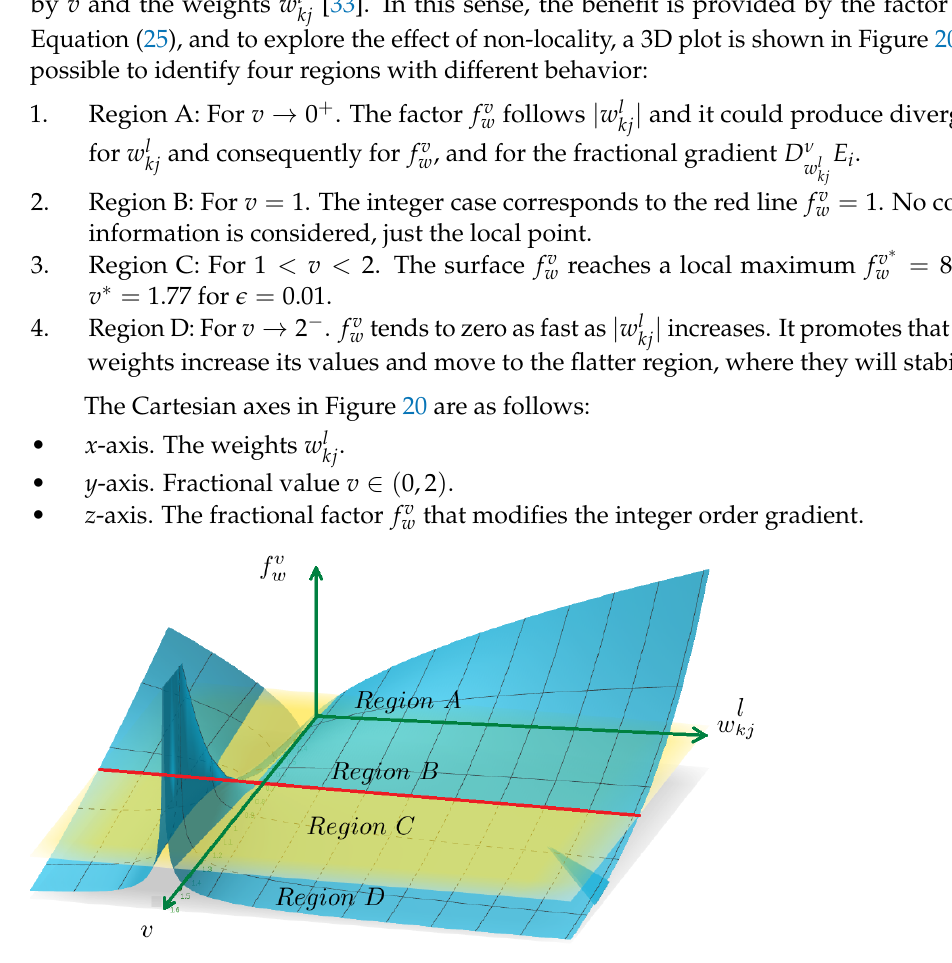
= 1 used as reference for the red line of the w